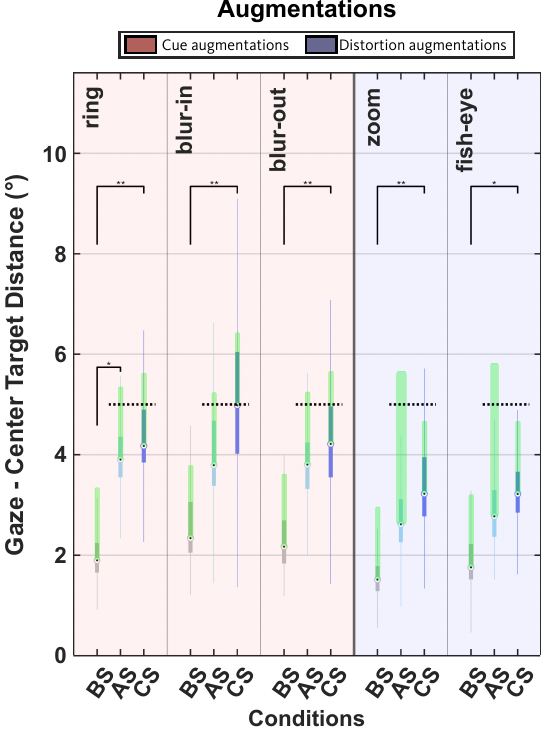
Figure 4. Box plots of the distance between gaze and target center for all the augmentations and all the three conditions (baseline (BS), augmented scotoma (AS), and central scotoma (CS)) tested. The asterisks above the box plots indicate the post hoc Dunn p -values, one for p -values ≤ 0.05 and two for p -values ≤ 0.01. The green rectangles represent the target radius, and the dotted lines are where the edge of the scotoma was considering the latency error. The target is distorted for the zoom and fish-eye during the augmentation condition. Zoom induced a 2.11 multiplication factor on both height and width, while the fish-eye generated a magnification of 2.11 on height and 1.66 on